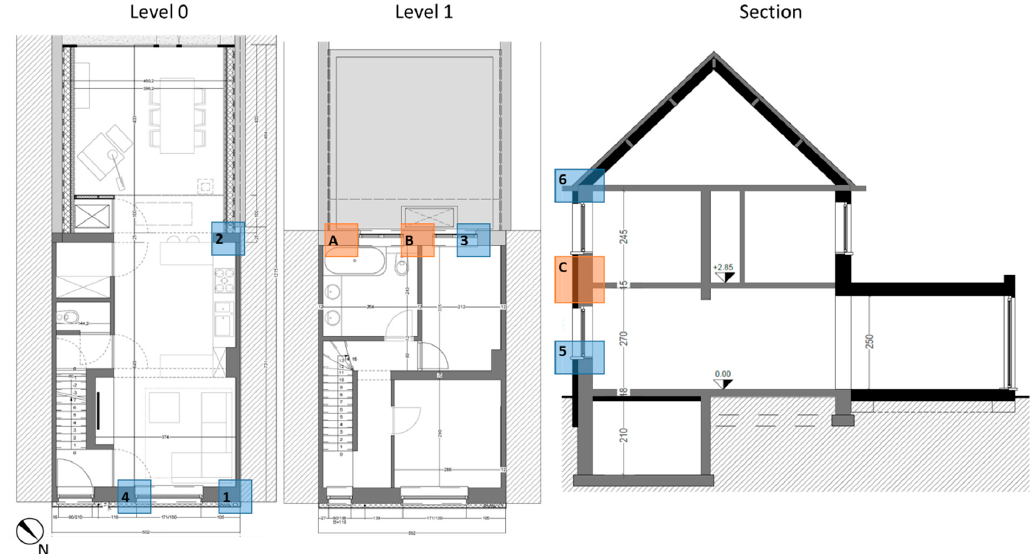
Figure 1. Floor plans of the case study with six thermal bridges indicated in blue (see Sections 3.1.2 and 4.1.1) and three simulated building components in orange (see Sections 3.2.2 and 4.2.3)—measures in cm.